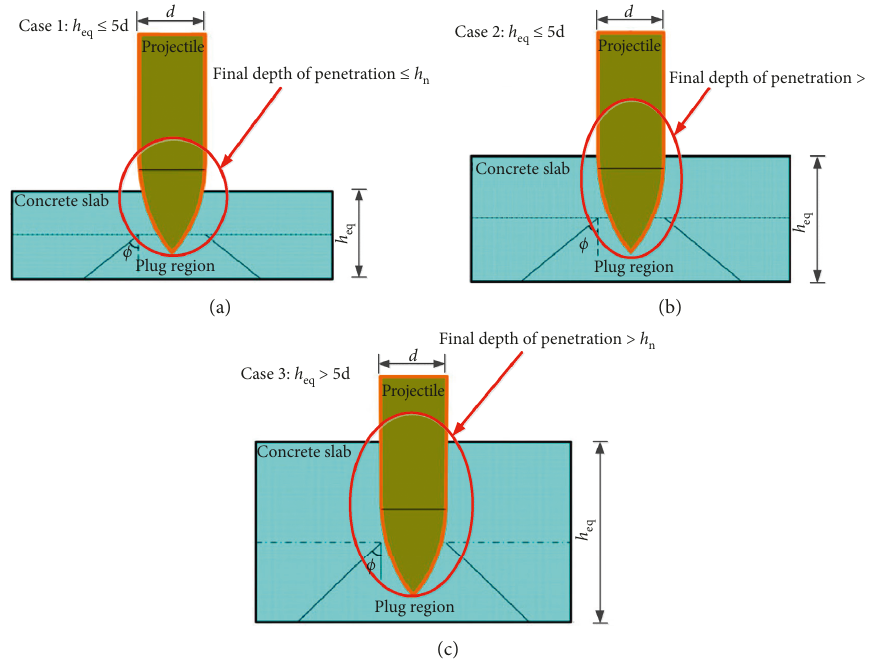
Figure 3: Schematics of perforation scenarios corresponding to the improved equation (9).